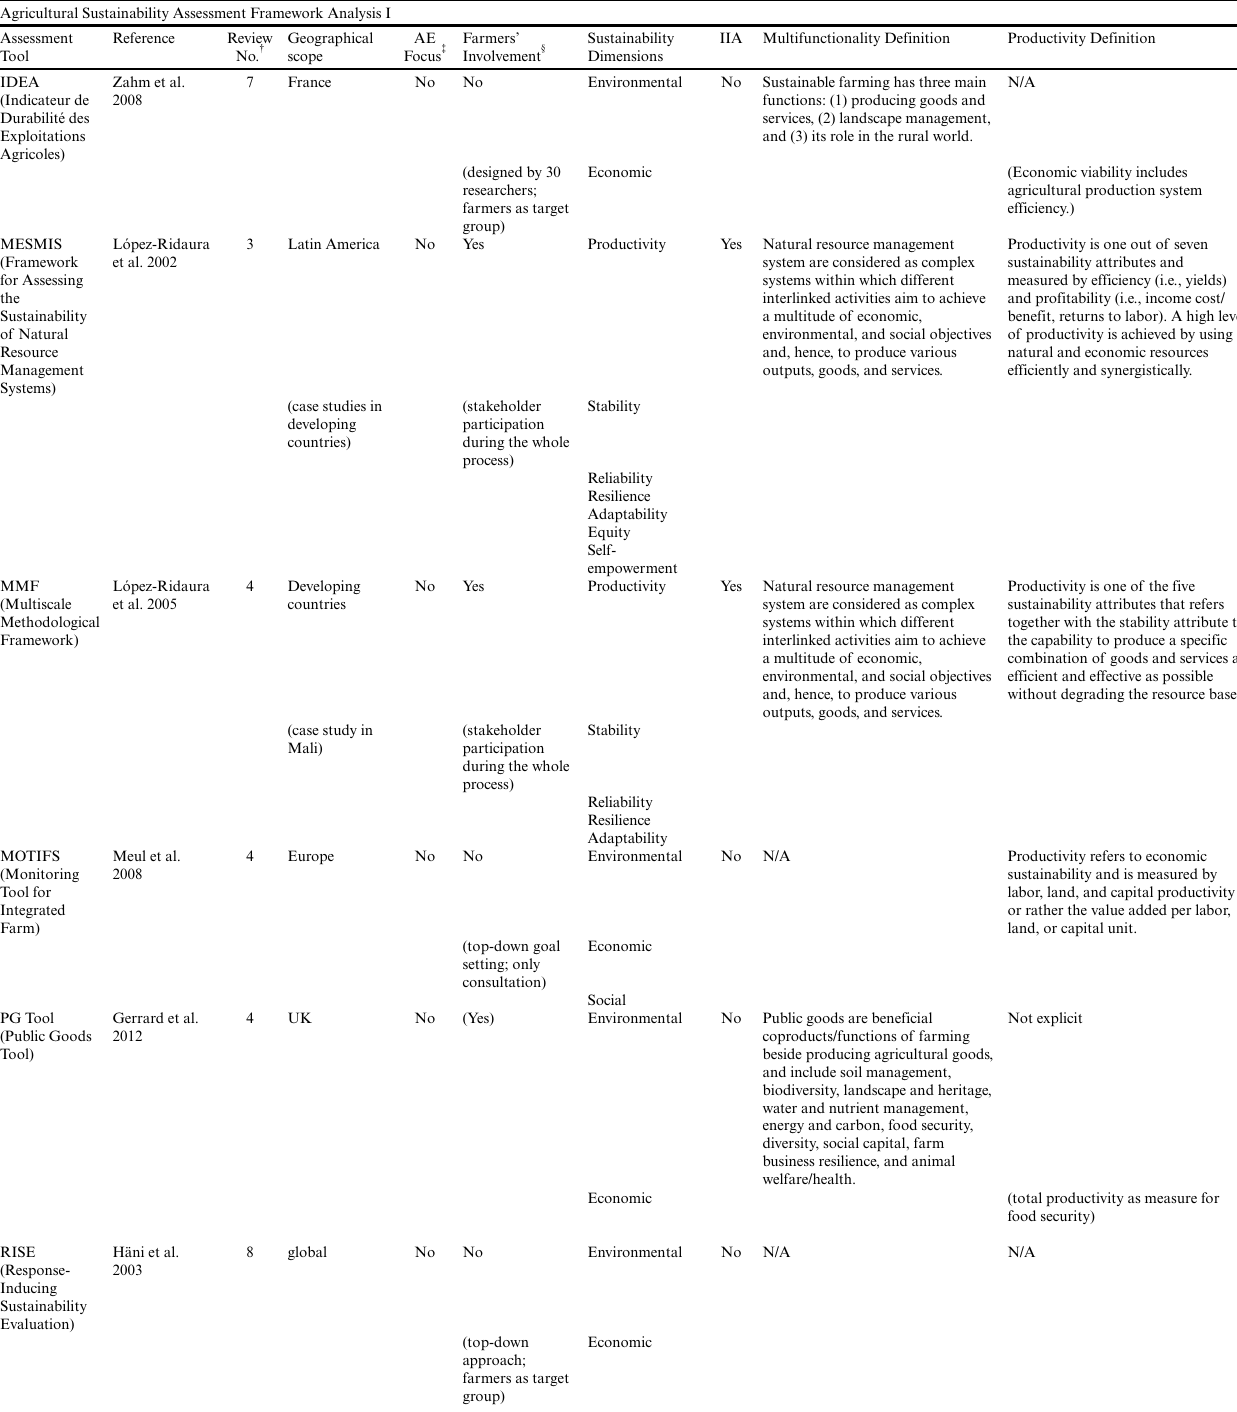
Table 3 . Framework analysis I. Evaluation criteria of the analysis of the integrated indicator-based agricultural sustainability assessment frameworks at the farm-level that were reviewed in the literature were the geographical scope, the focus on agroecology (i.e., AE focus), the sustainability dimensions, and the involvement of the farmers in the development process of the framework, the implementation of an indictor interaction analysis (IIA), and the definition of multifunctionality and